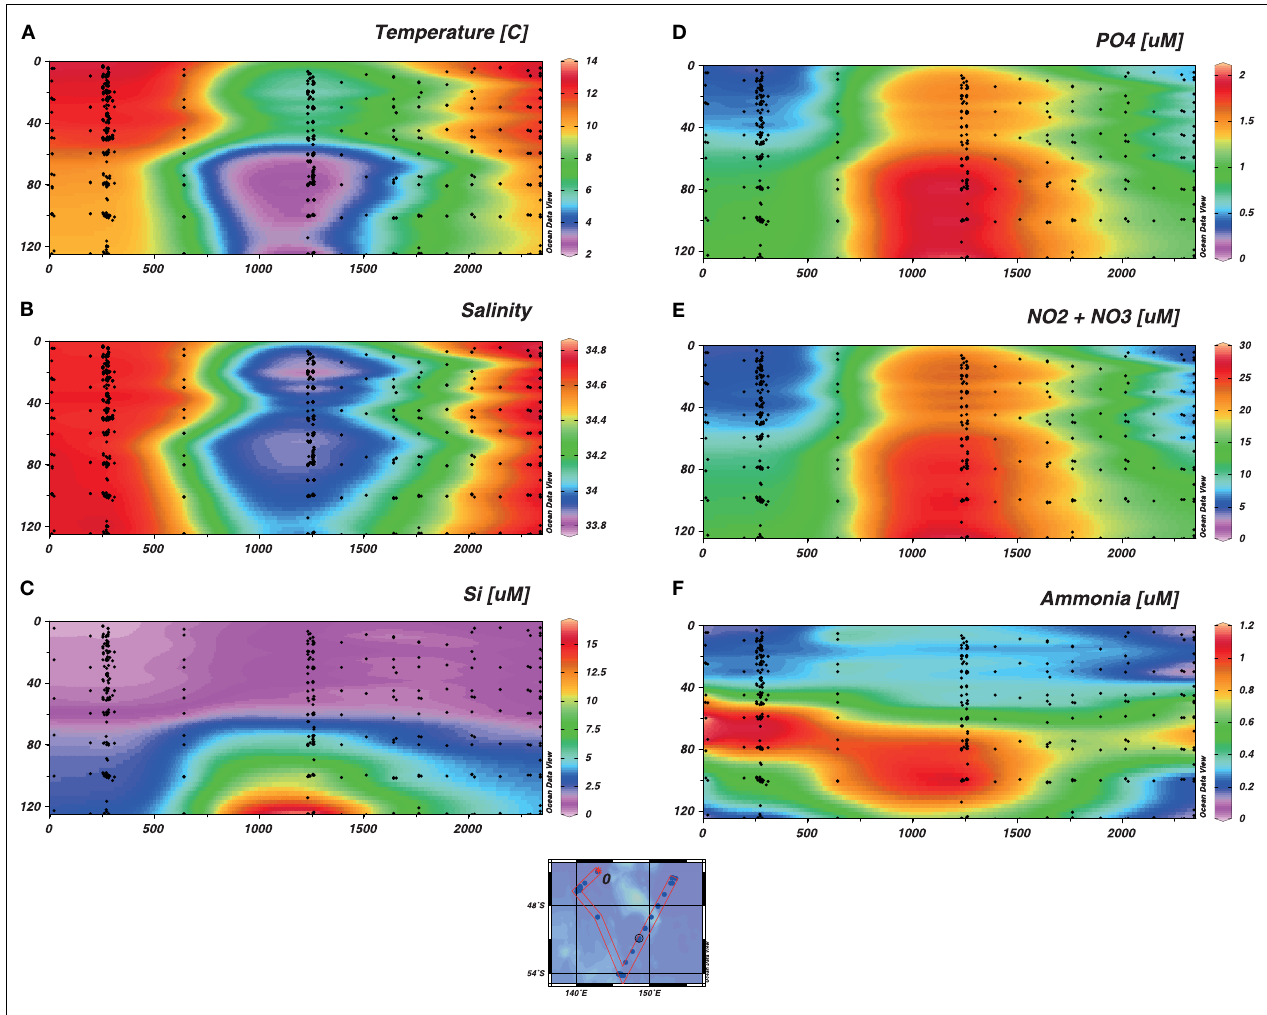
the PFZ (Stn 6) in the center and the E-SAZ (Stn 17) the last on the right.The temperature (A) , salinity (B) and macronutrients [Si (C) ; PO 4 , (D) ; NO x , (E) ; and ammonia, (F) ] are